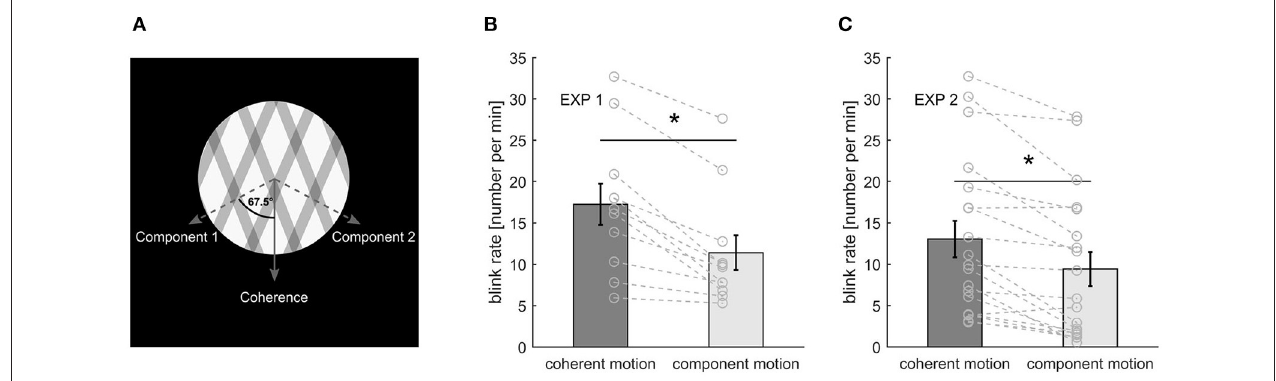
FIGURE 1 | (A) Stimulus representation. (B) Blink rate during the different percepts in experiment 1. (C) Blink rate for the different percepts in experiment. Bars and error bars represent mean ± standard error of the mean (SEM). Gray lines represent data of individual participants. An asterisk marks a significant difference at p <